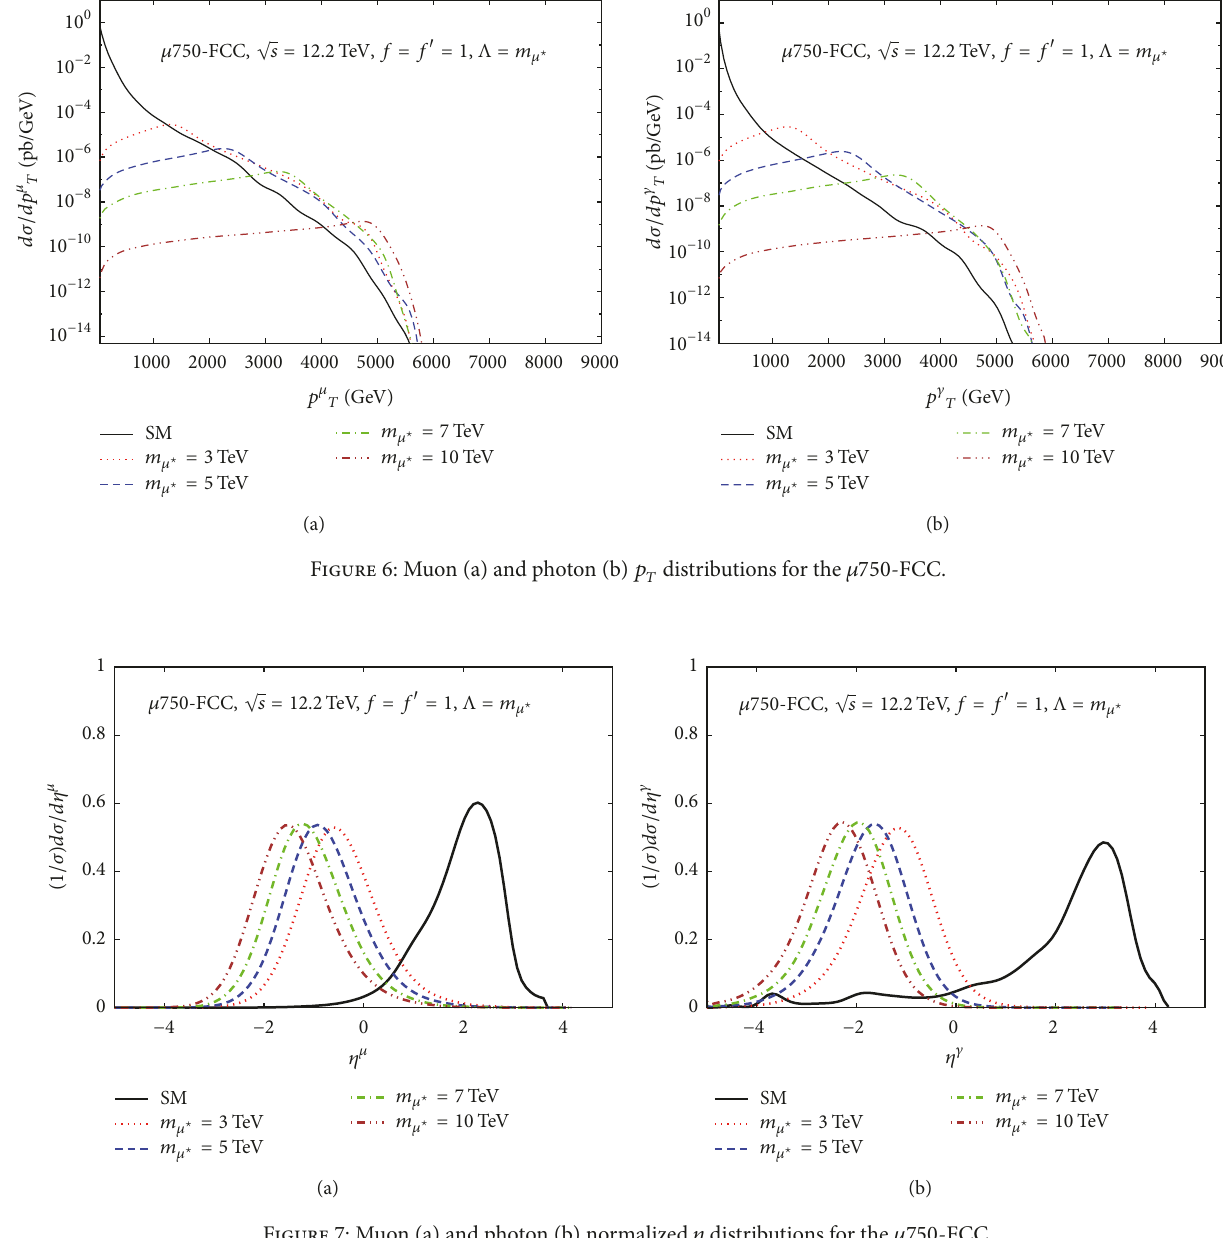
Figure 7: Muon (a) and photon (b) normalized 𝜂 distributions for the 𝜇750